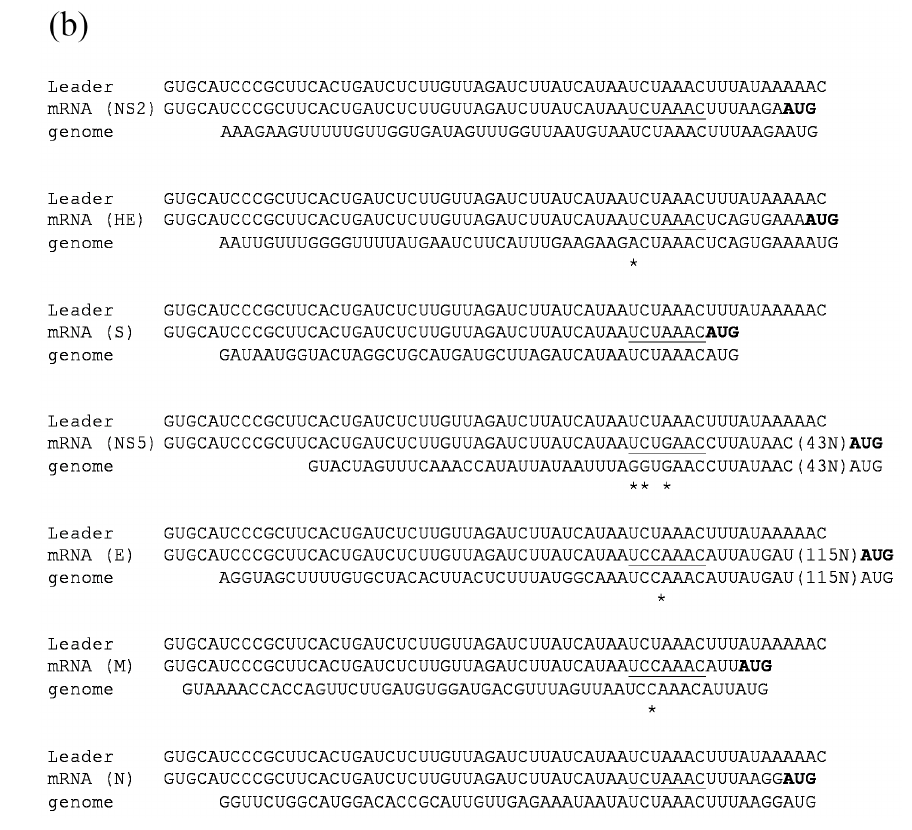
Figure 2. ( a ) Northern blot analysis for total RNA isolated from dromedary camel coronavirus (DcCoV) UAE-HKU23–infected HRT-18G cells. RNA species are indicated by arrows. NS2, non-structural NS2; HE, hemagglutinin; S, spike; NS5, non-structural NS5; E, envelope; M, membrane; N, nucleocapsid. Lane 1, 1 µ g total RNA from uninfected cells; Lane 2, 1 µ g total RNA from infected cells; ( b ) DcCoV UAE-HKU23 subgenomic mRNA (sg mRNA) leader-body junction and flanking sequences. The subgenomic mRNA sequences are shown in alignment with the leader and the genomic sequences. The start codon AUG in each subgenomic mRNA is depicted in bold. The putative transcription regulatory sequences (TRS) was underlined and base mismatch between the body TRS and the leader TRS or the corresponding genomic region was indicated by asterisk. The 43N and 115N in the parentheses indicate that 43 and 115 nucleotides at that region are not shown.